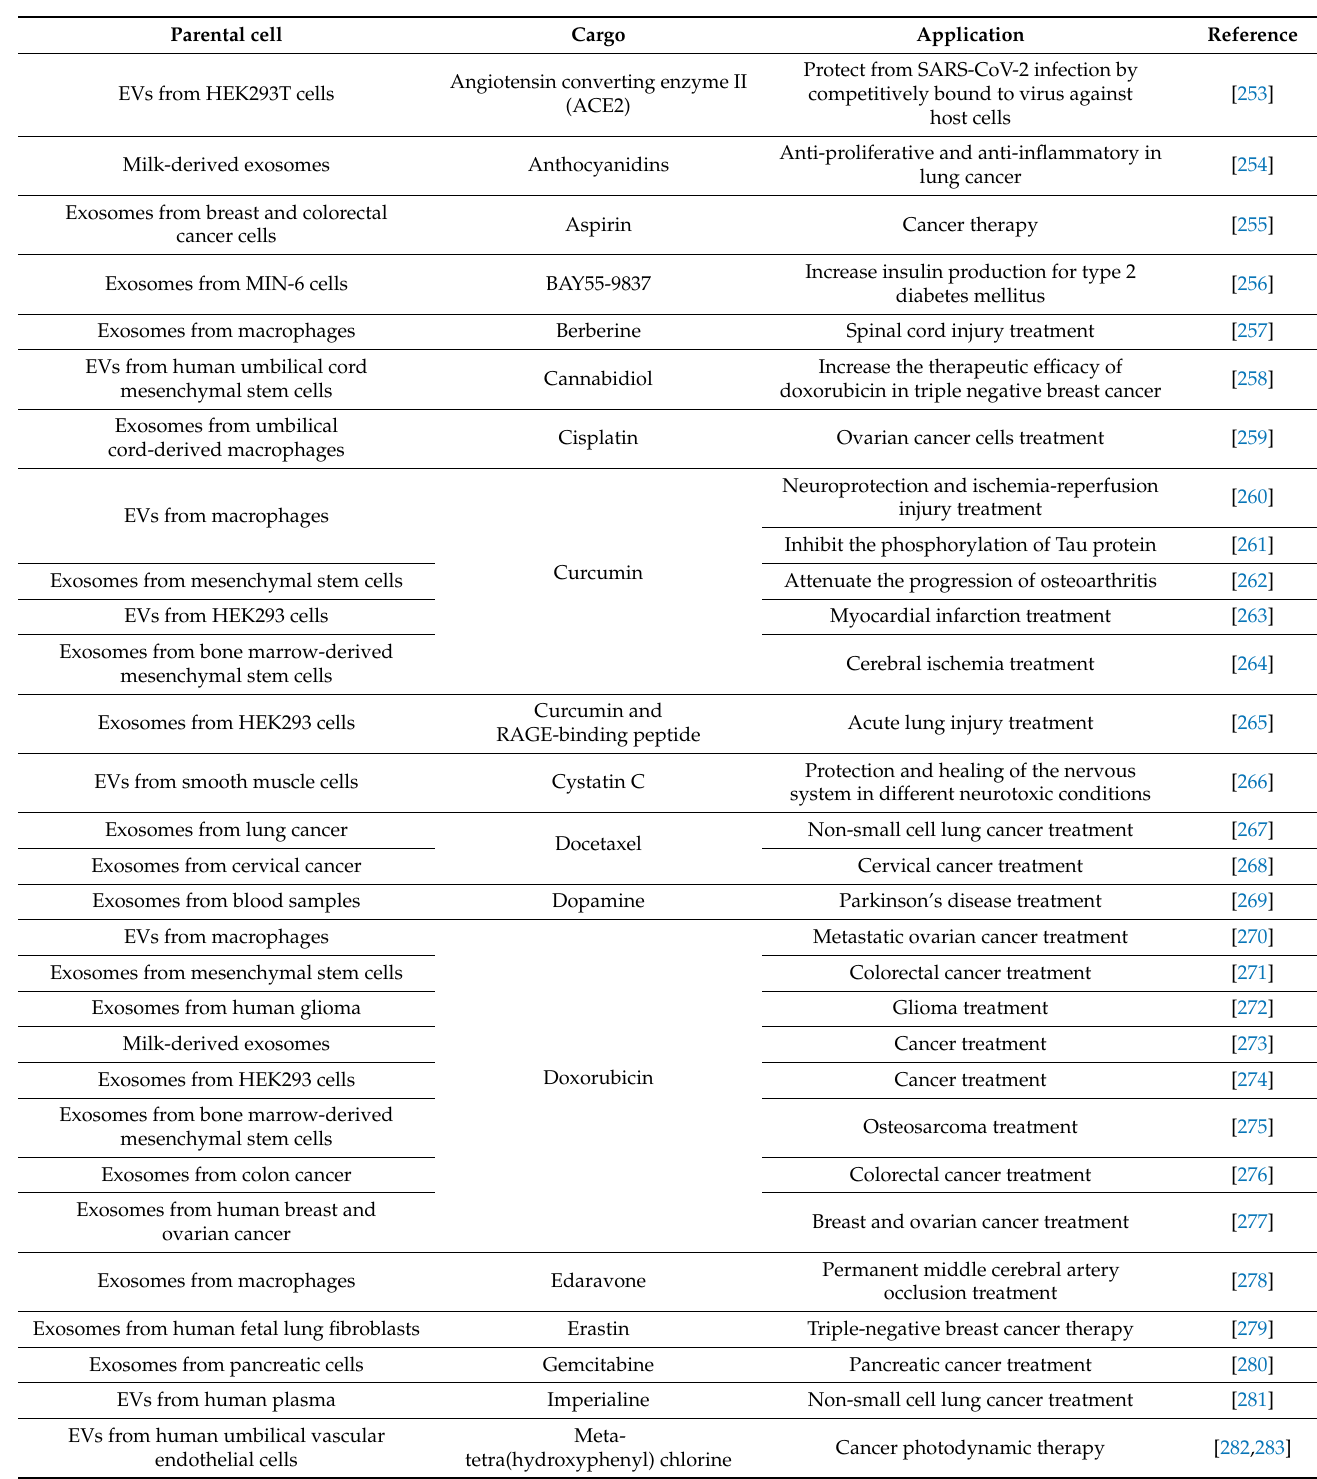
Table 9. Extracellular vesicles’ drug delivery